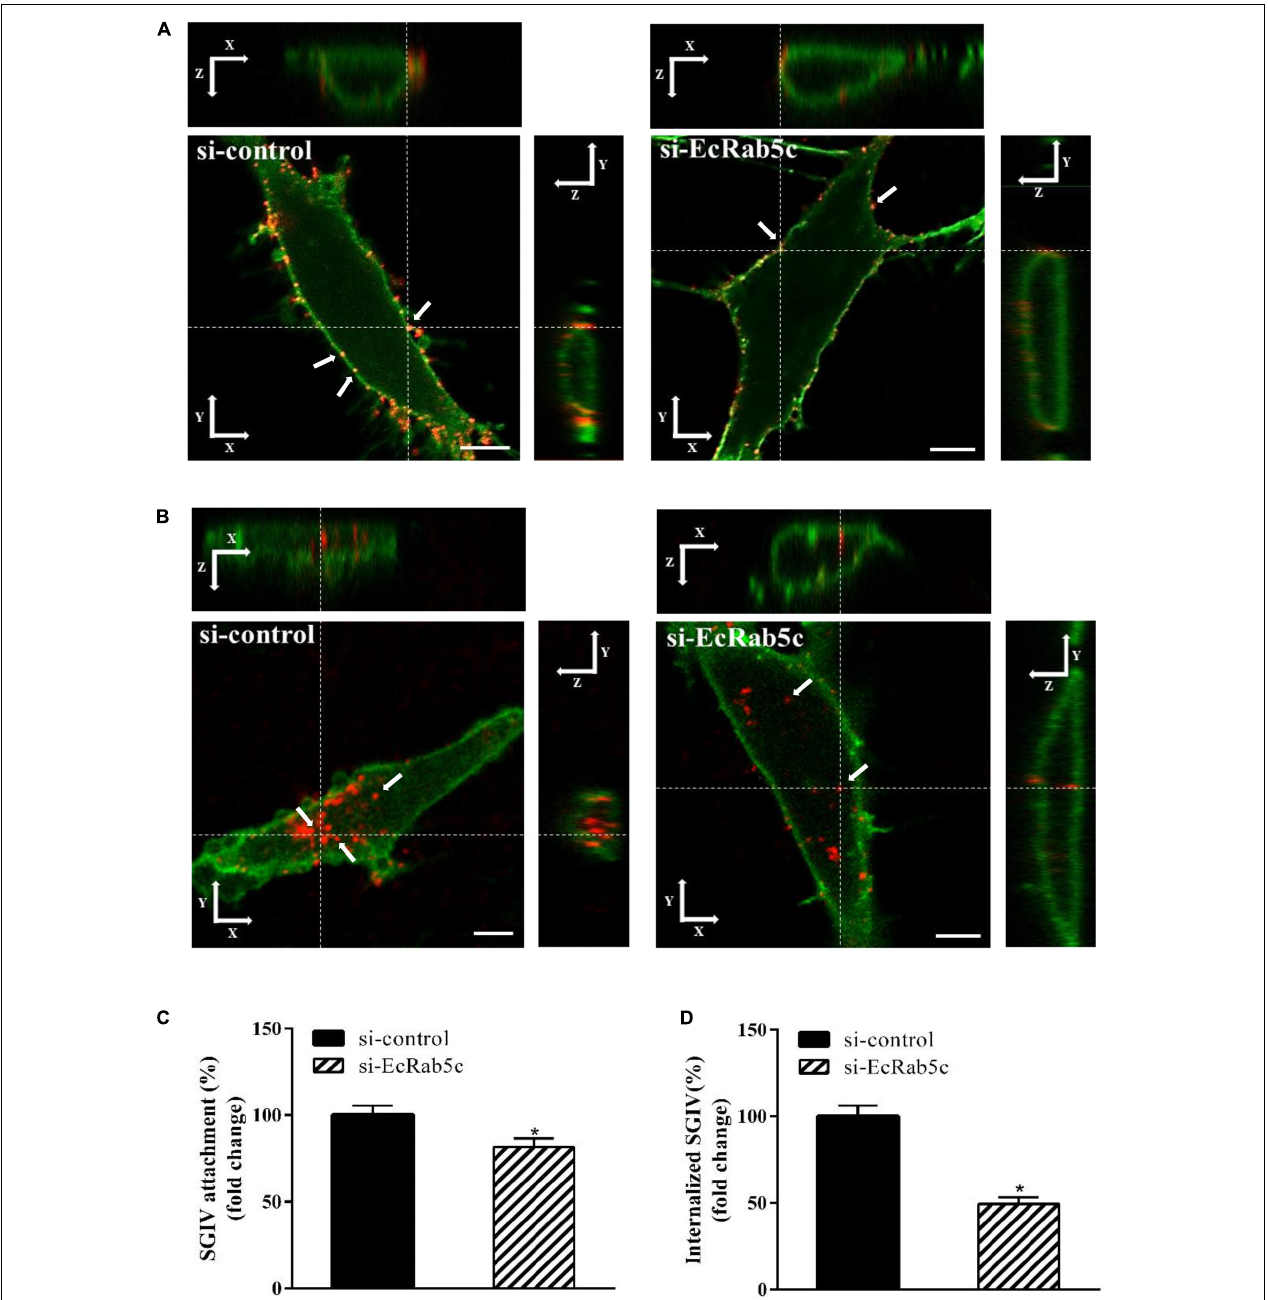
FIGURE 3 | Knockdown of EcRab5c by siRNA affects the attachment and entry of SGIV. (A) Three-dimensional (3D) confocal images of SGIV attachment in si-control or si-EcRab5c transfected cells. GS cells were transfected with si-control or si-EcRab5c, incubated with Alexa-Fluor 647 labeled SGIV (red) at 4 ◦ C for 1 h, and then fixed with paraformaldehyde. The cells were stained with DiO to show the cell membrane (green), and observed by confocal microscope. White arrow indicated SGIV particles. Scale bars shown as 5 µ m. (B) 3D confocal images of SGIV internalization in si-control or si-EcRab5c transfected cells. After transfection with si-control or si-EcRab5c, GS cells were incubated with Alex-Fluor 647 labeled SGIV (red) at 4 ◦ C for 20 min, and then the temperature was transferred to 28 ◦ C to initiate infection. The cells were fixed at 1 hpi. The samples were stained with DiO to indicate the cell boundaries (green). White arrow indicated SGIV particles. Scale bars represent 5 µ m. (C) Quantification of SGIV particle binding on the cell membrane. More than 90 cells were randomly selected and analyzed by MATLAB program. The SGIV attachment was quantified as the percentage of virus particles binding on the cell membrane in si-EcRab5c transfected cells relative to that in si-control transfected cells. The value in control cells was arbitrarily set as 100%. The data are indicated as the means ± SEM. * p < 0.05. (D) Quantification of internalized SGIV particles. Over 90 cells were randomly selected and analyzed by MATLAB program. The SGIV uptake was quantified as the percentage of internalized virus particles in si-EcRab5c transfected cells relative to that in si-control transfected cells. The value in control cells was arbitrarily set as 100%. The data are indicated as the means ± SEM. * p < 0.05.